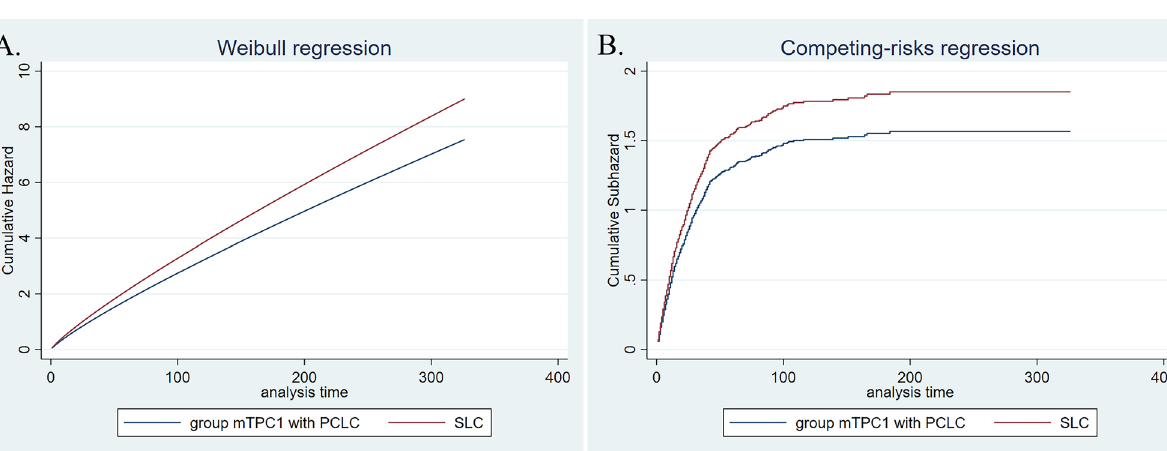
Figure 2. Adjusted cumulative hazard of all-cause death ( A ) and cancer-specific death ( B ) in sTPC group with PCLC and matched single lung cancer.